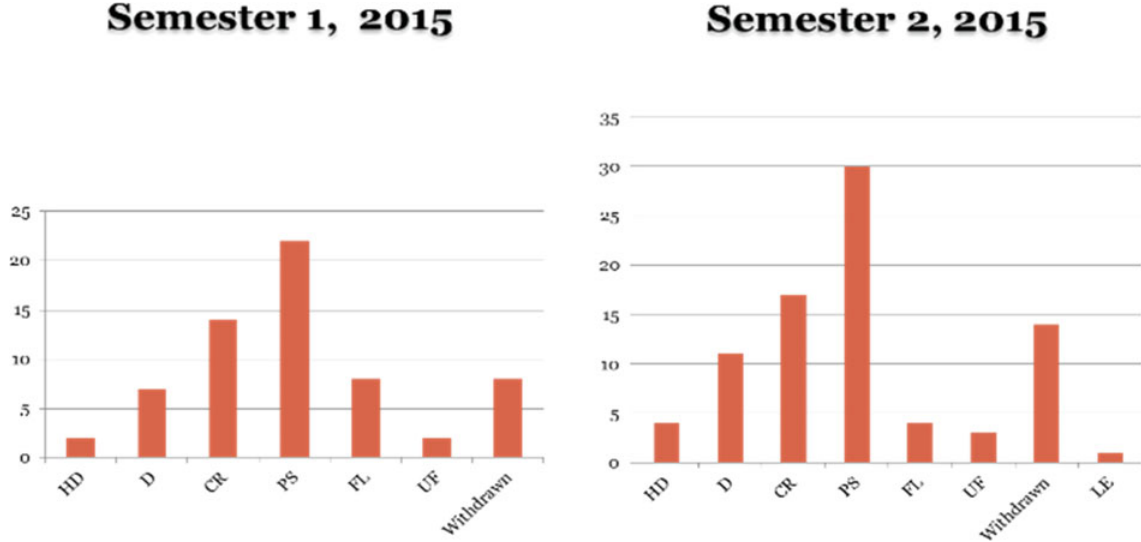
Figure 3. (Colour online) Student performance in maths